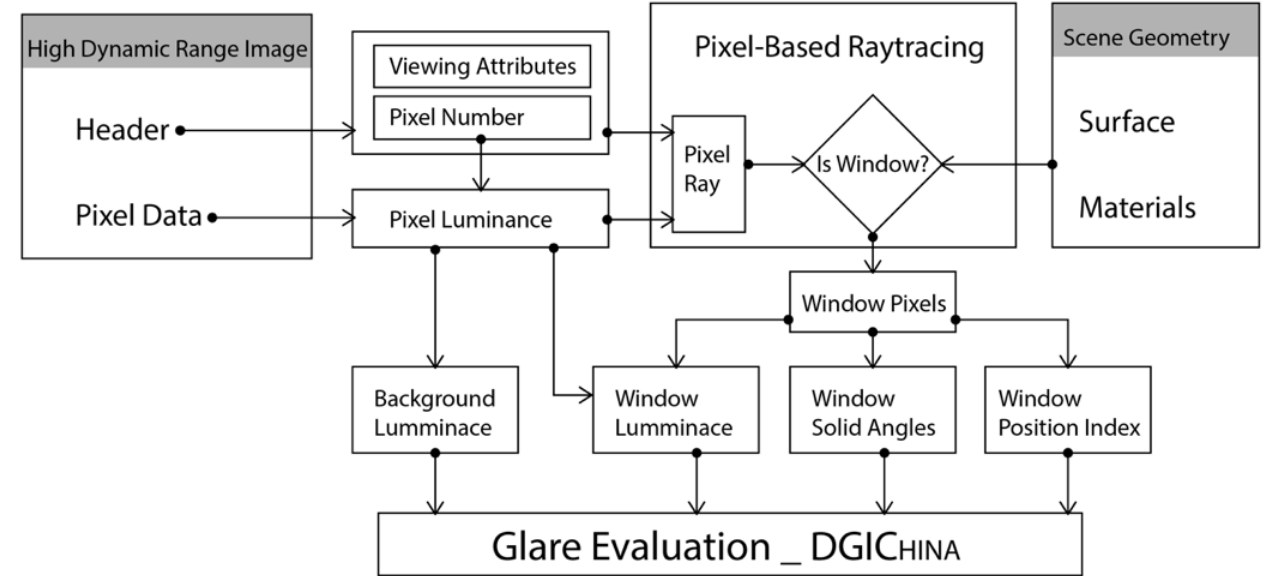
Figure 5. The DGI Evaluation workflow.